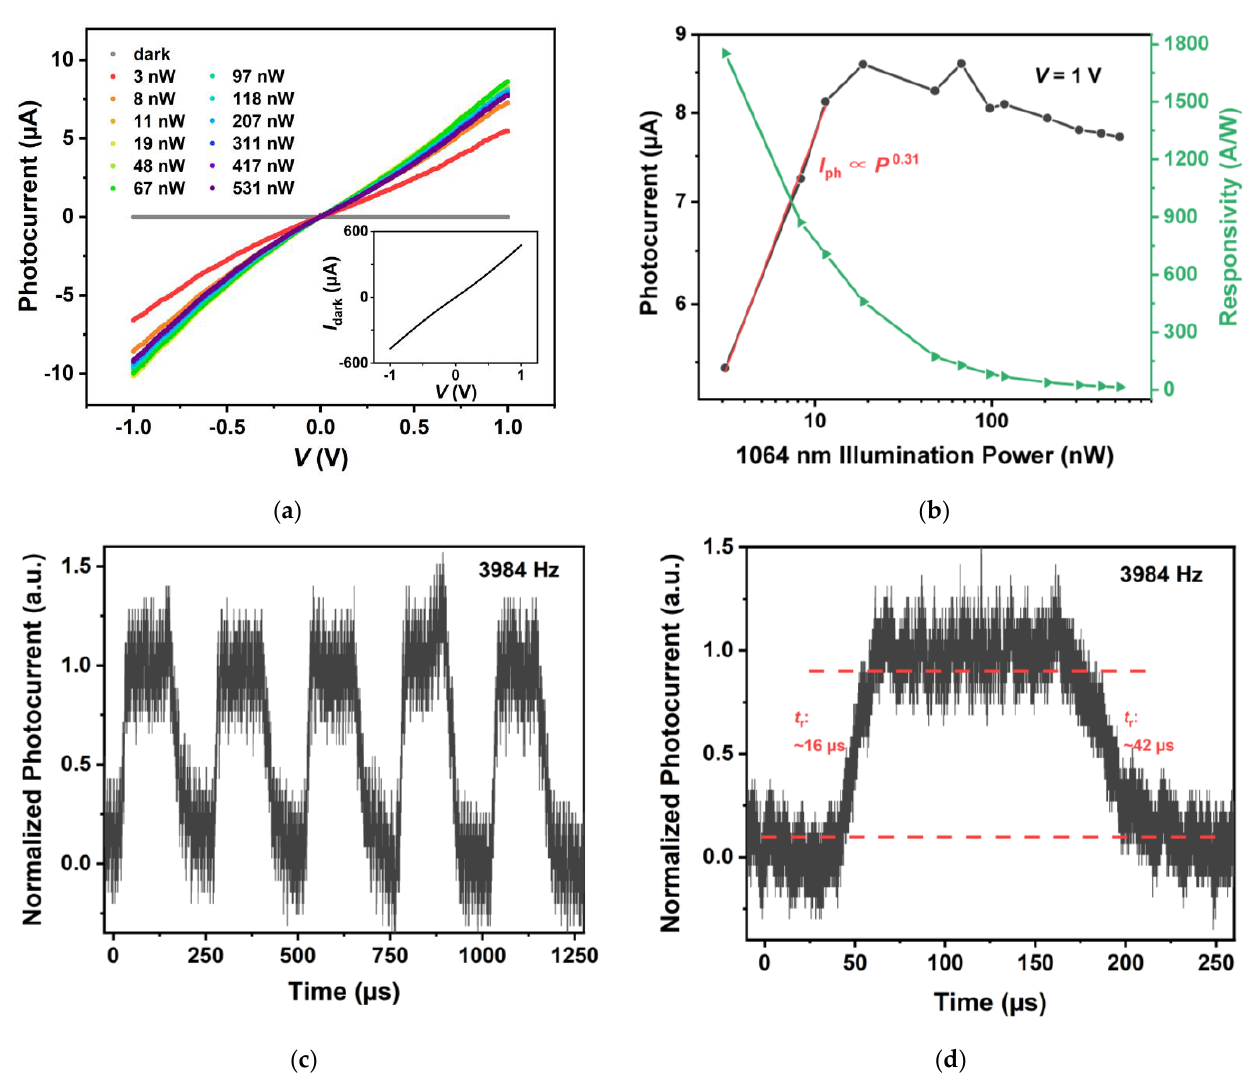
Figure 6. The photoresponse performance of an Al 2 O 3 (20 nm thick)-encapsulated vertical heterostructure device (device 2): ( a ) the I ph — V curves under 1064 nm laser illumination with different illumination power from 3 nW to 531 nW. Inset: The I — V curve under dark conditions; ( b ) the I ph and illumination power relation (the black line), and the responsivity and illumination power relation (the green line) measured at V = 1 V. The red line is the fitted curve with the equation I ph = aP b , where a and b are fitted constants; ( c ) the normalized photocurrent waveform under chopped 1064 nm laser illumination. The chopping frequency is 3984 Hz; ( d ) a single normalized response cycle. The t r ( t f ) of 16 µs (42 µs) is acquired.